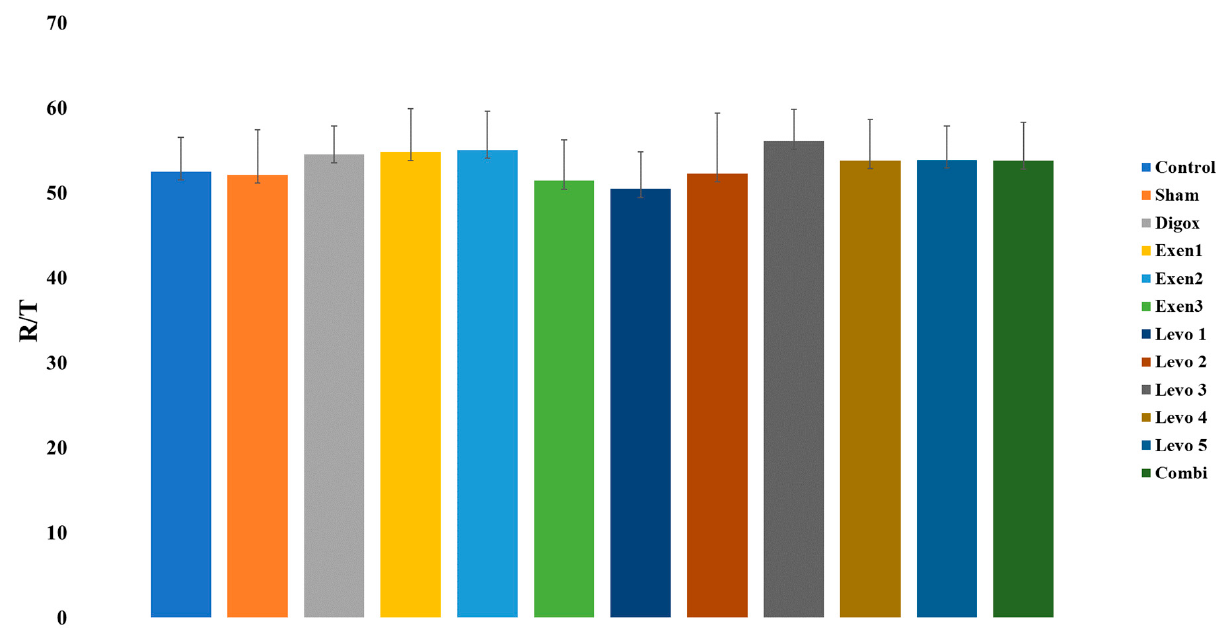
Figure 16. Changes in R/T across groups.